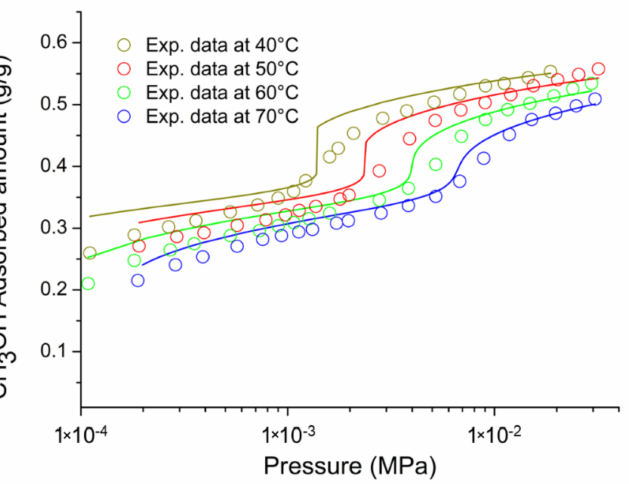
Figure 11. Comparison between experimental data [58] and simultaneous optimized model fitting (solid